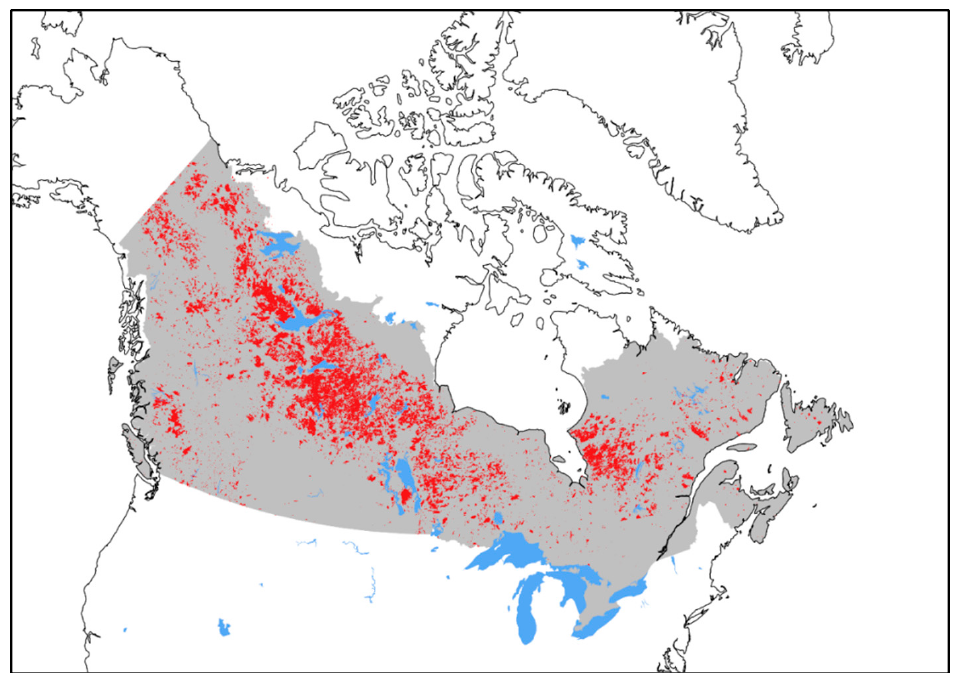
Figure 2. Spatial extent of the WildFireSat Area of Interest (AoI), which includes the entire continuously vegetated extent of Canada (gray). For context, the historic burned area on public, primarily forested lands (1980–2019) is overlaid in red [17]. Although the full AoI is not prone to frequent wildfire activity, the vegetated areas shown here are burnable. The spatial distribution of wildfire within the AoI is expected to change under climate change. The distribution of agricultural burning (primarily confined to the southern half of the AoI) is not shown.